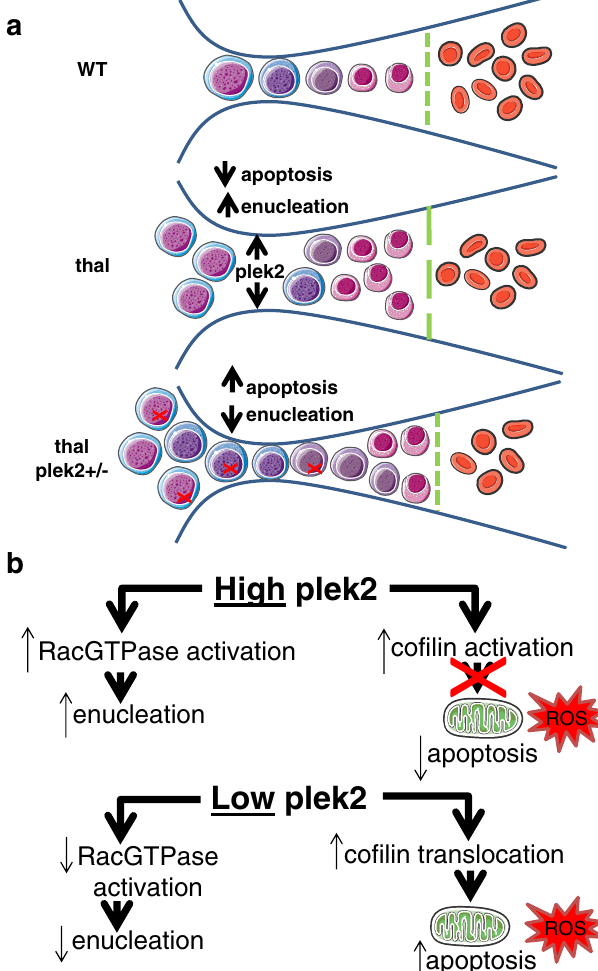
Fig. 7 Mechanism by which pleckstrin-2 supports proliferation, decreases apoptosis, and enhances enucleation in ineffective erythropoiesis. a The normal balance of differentiation and proliferation enables effective erythropoiesis in WT mouse bone marrow. In β -thalassemic bone marrows, ineffective erythropoiesis results from an imbalance, with relatively more proliferating erythroblasts that differentiate and enucleate to form mature RBCs. When ROS are increased in β -thalassemic erythroblasts, elevated Epo enables multiple downstream mechanisms. Plek2 serves as a mechanism downstream of Epo by which more β -thalassemic erythroblasts evade apoptosis and increase erythroblast enucleation (green line). In thal plek2 + / − bone marrow, more erythroblasts undergo apoptosis (red X) and fewer enucleate (green line), resulting in worsening anemia compared with β -thalassemic mice. b When membrane-associated pleckstrin-2 is increased, it ’ s binding to co fi lin and consequent prevention of co fi lin translocation to the mitochondria results in decreased apoptosis despite elevation of ROS in β -thalassemic erythroblasts. In addition, interaction with and activation of Rac1 results in enhanced enucleation in high-pleckstrin-2 states. Thus, when membrane-associated pleckstrin-2 is decreased in the setting of increased erythroblast ROS, relatively more co fi lin translocation to the mitochondria leads to apoptosis and decreased Rac1 activation results in relatively decreased enucleation, leading to worsening ineffective erythropoiesis in β -thalassemia. WT = wild type; thal = β -thalassemia; plek2 = pleckstrin-2; ROS = reactive oxygen